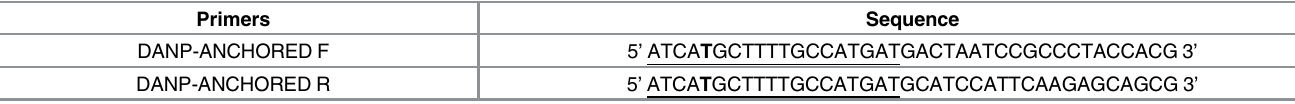
Table 1. DANP-anchored hairpin primer sequences used for detection of